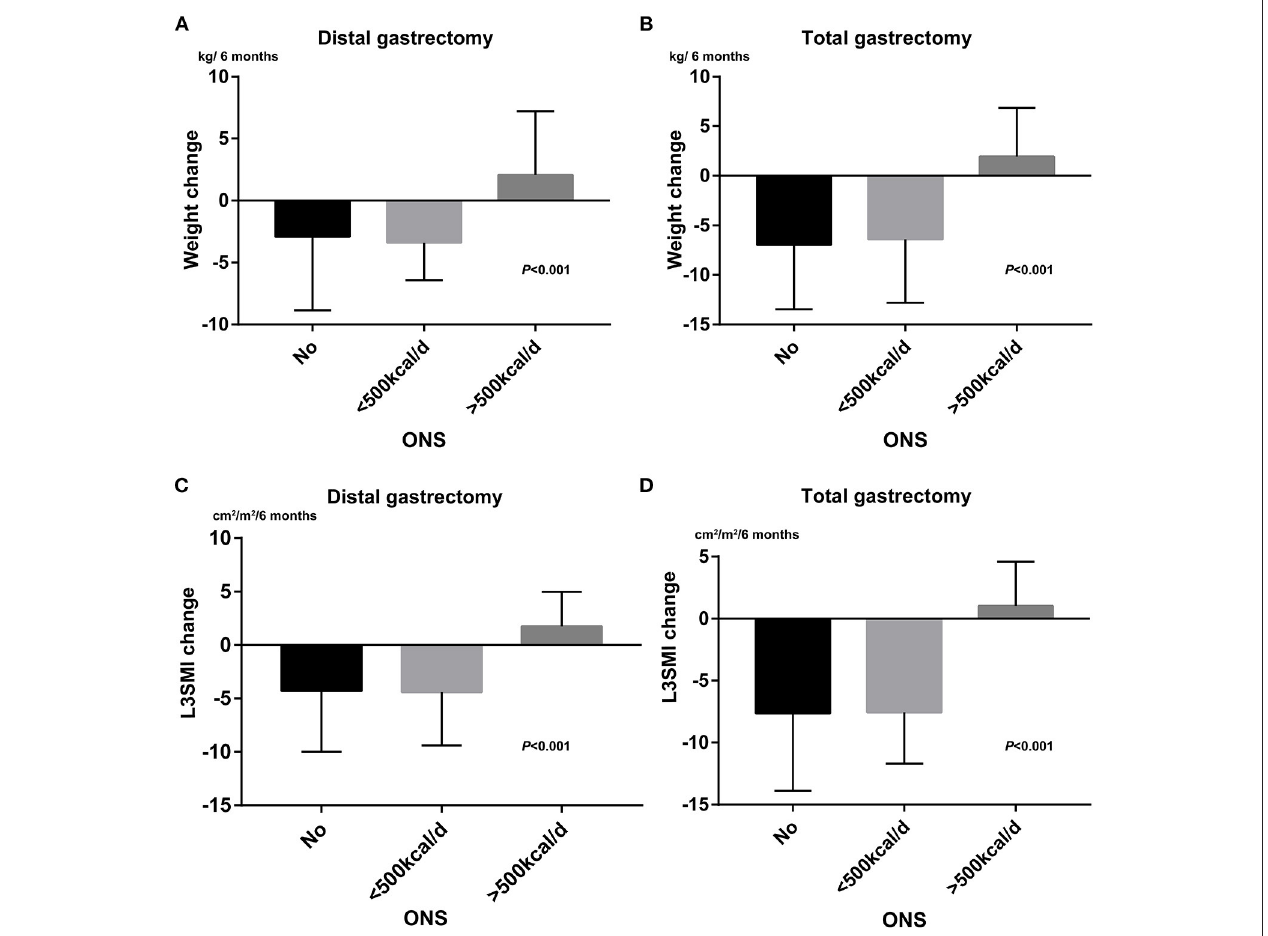
FIGURE 1 | The effects of ONS administration on weight loss and L3SMI loss. (A) Bar chart for weight change between different ONS group after distal gastrectomy. (B) Bar chart for weight change between different ONS group after total gastrostomy. (C) Bar chart for L3SMI change between different ONS group after distal gastrectomy. (D) Bar chart for L3SMI change between different ONS group after total gastrectomy.